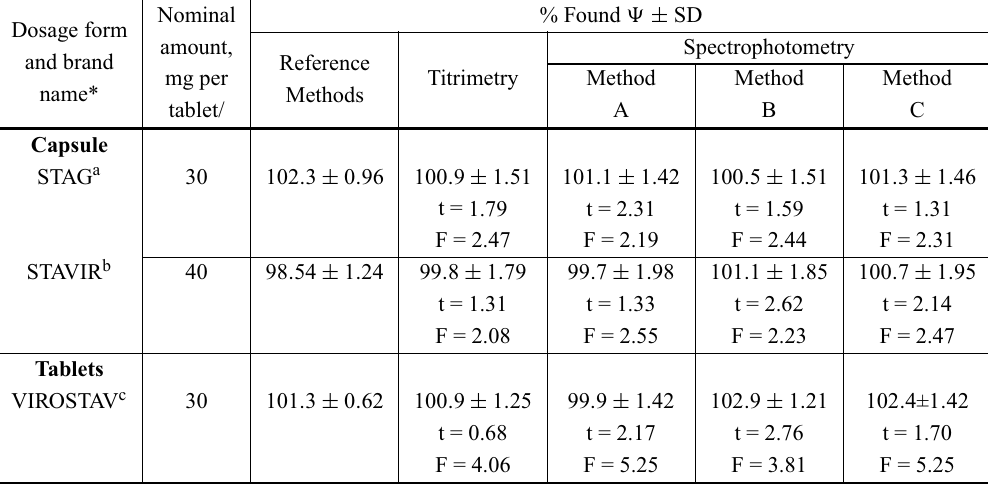
Results of assay of STV in dosage forms by proposed methods and statistical comparision with reference